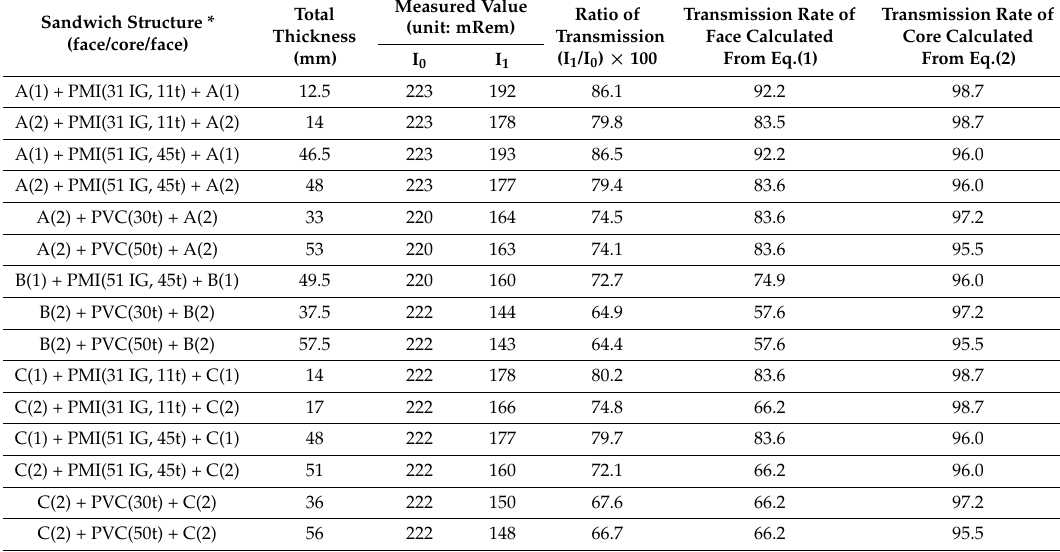
Table 5. X-ray Transmission Ratios for Sandwich Structure.